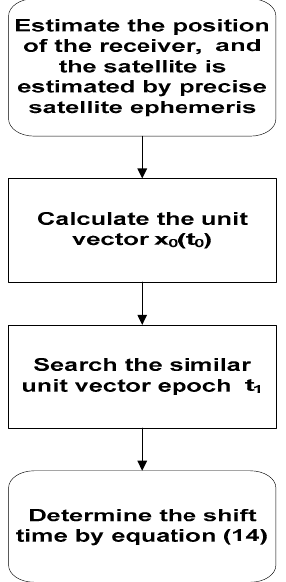
Figure 1. Flowchart of the aspect repeat time method.